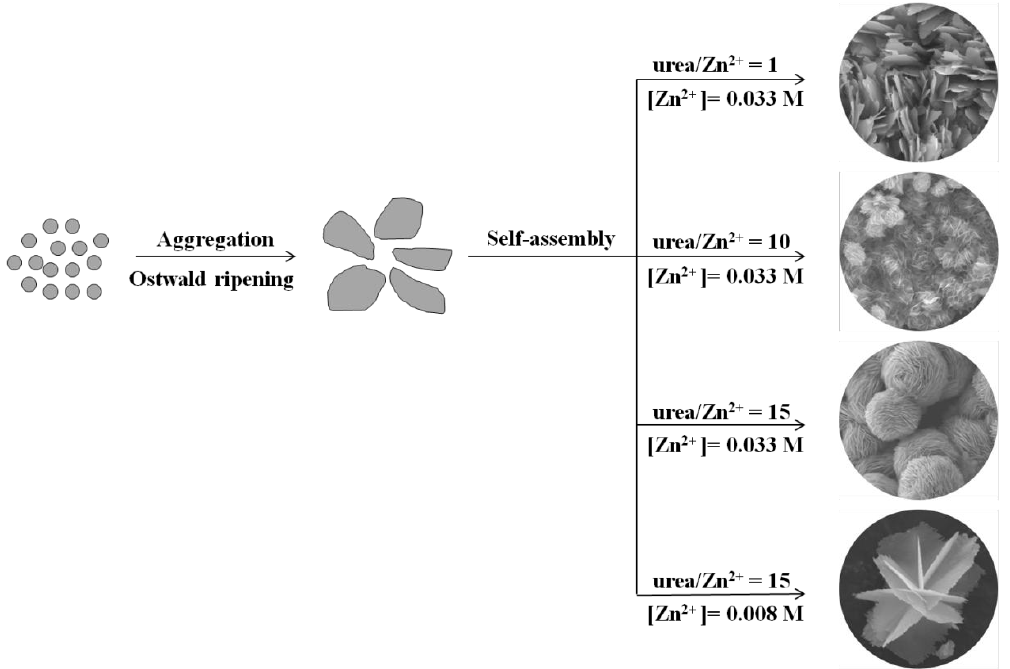
Figure 6. Typical N gas adsorption-desorption isotherm of the F3, F5 and commercial 2 ZnO samples. Insets: the corresponding pore-size